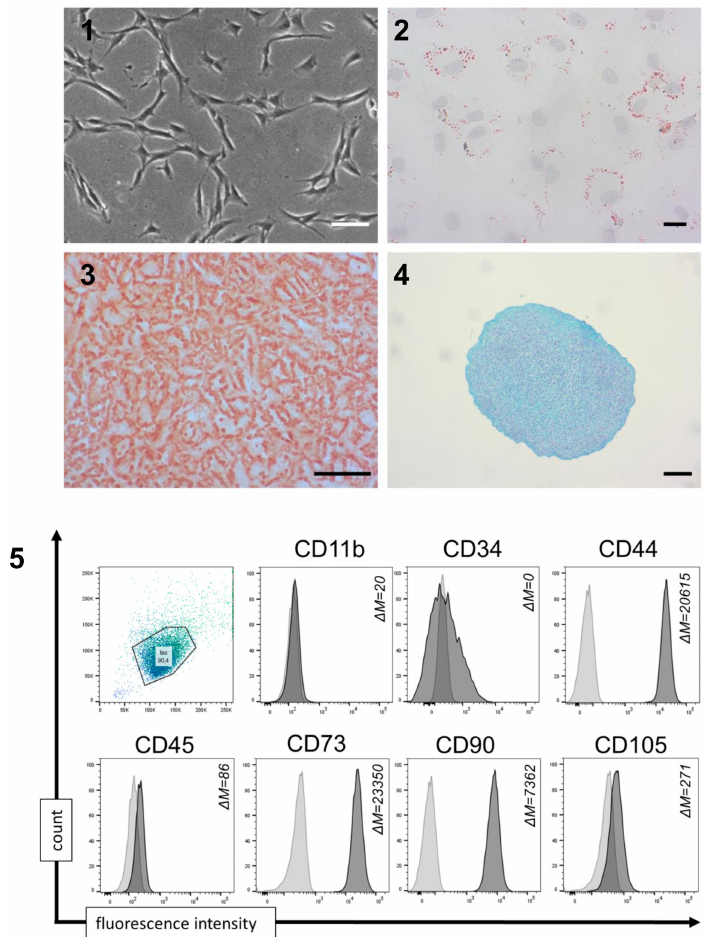
Figure 2. Characterization of nasal mucosa mesenchymal stem cells (mMSCs). ( 1 ) Representative images from mMSCs in passage 4 to 6 after isolation (mMSC3; scale bar 100 µ m), ( 2 – 4 ) Representative images of immunohistochemistry staining of nasal mucosa MSCs for successful differentiation into adipocytes, osteocytes, and chondrocytes. ( 2 ) Adipogenic differentiation is detected with Oil Red O staining, ( 3 ) osteogenic differentiation is detected with Alizarin Red, and ( 4 ) chondrogenic differentiation is detected with Alcian Blue (scale bar 100 µ m). ( 5 ) Representative diagrams of flow cytometric analyses of nasal mMSCs at passage 4–6 (n = 4) for cell surface markers being expressed (CD44, CD73, CD90, and CD105) and cell surface markers being absent (CD11b, CD34, and CD45). Data are shown as an overlay histogram with the isotype control (light gray) and cell surface marker staining (dark gray) ( ∆ M = mean fluorescence intensity, MFI; difference between MFI measure and isotype